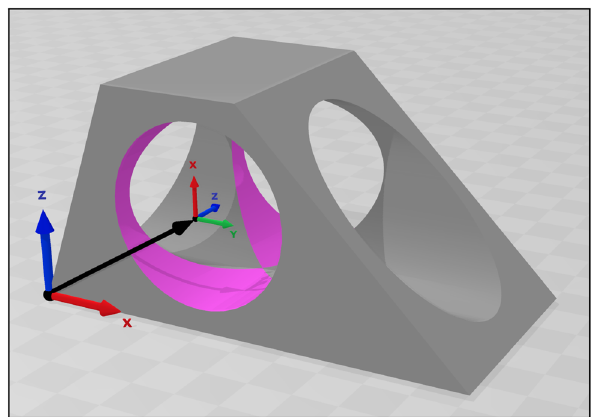
Figure 3: Sample part 1 recreated from the study by Cheng et al. [ 9 ] with coordinate